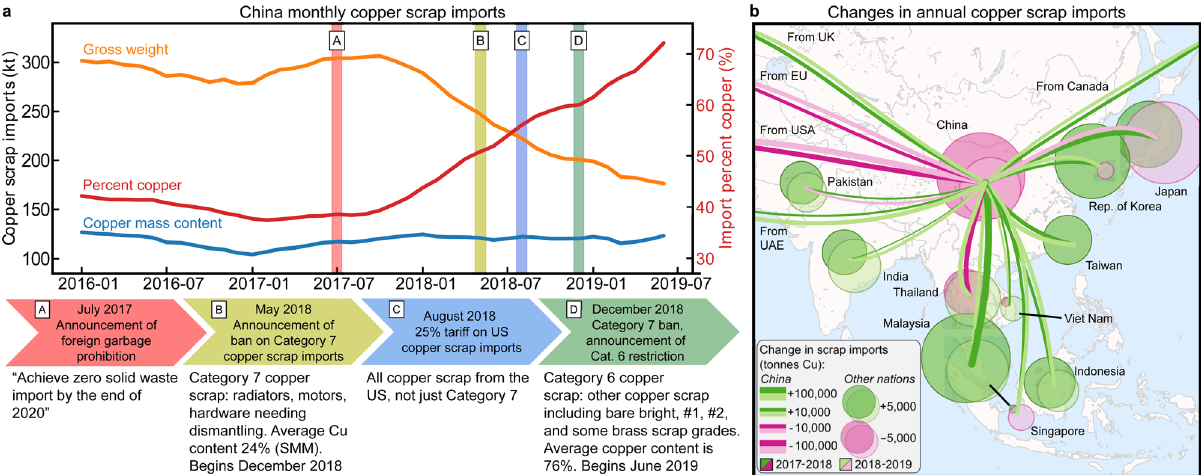
Fig. 2 Changes in monthly and annual copper scrap imports for China and surrounding region. a China ’ s scrap-related policy actions and the consequent decrease in gross weight scrap imports (yellow), increase in the percent copper (red) for those imports, and the near-constant resulting copper mass content (blue). b Changes in the copper content of copper scrap imports for countries surrounding China and their exports to China, where year-over-year increases are shown in dark green (2017 – 2018) and light green (2018 – 2019), while decreases are shown in purple (2017 – 2018) and pink (2018 – 2019). Bubbles represent changes in the corresponding country ’ s copper imports, with 2017 – 2018 always shown above and left of center and 2018 – 2019 below and right of center, while lines represent changes in that country ’ s exports to China. Bubble diameters and line widths vary on logarithmic scales, with values reported in Supplementary Table 9. This fi gure is created using the matplotlib Basemap package in Python 75,76 . Underlying data used to create this fi gure may be found in a data repository at https://doi.org/10.6084/m9. fi